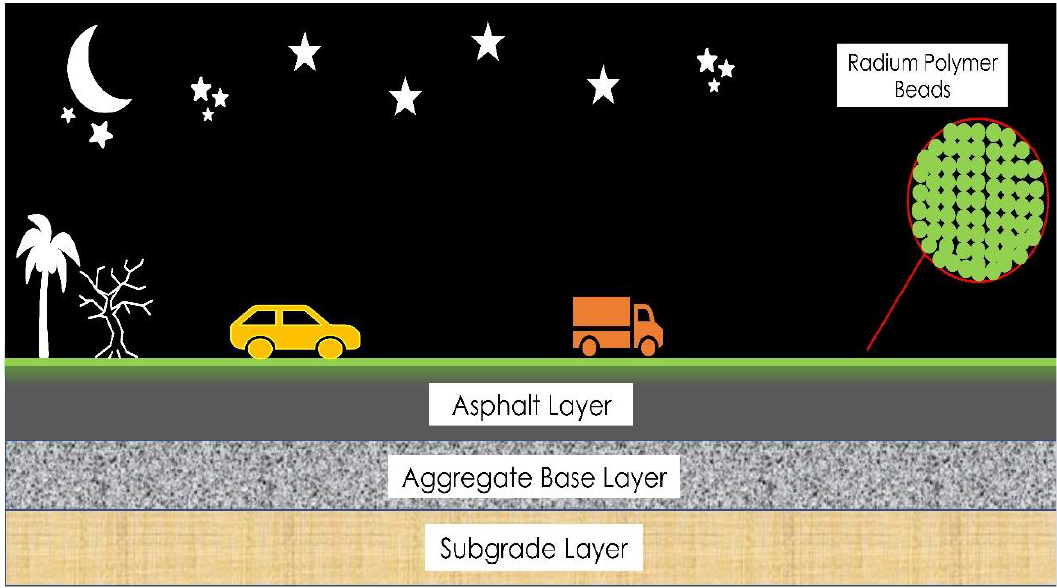
Figure 1. The proposed smart highways with radium polymer beads.